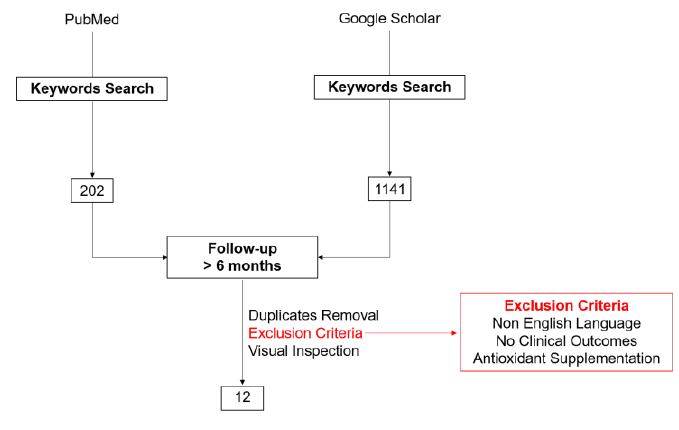
Figure 2. Flow diagram of the literature